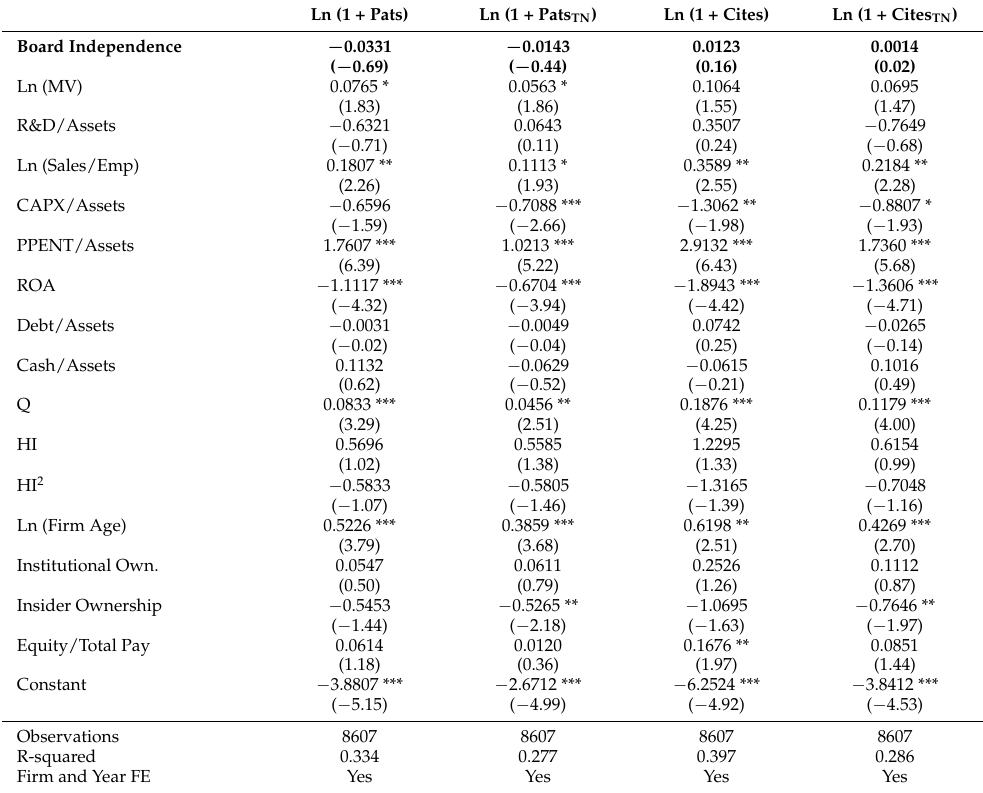
Table 8. Regressions of Innovation on Board Structure. This table presents regression results of Innovation on Board Independence, defined as the percentage of directors who are independent. All except binary variables are winsorized at the upper and lower 1% levels. Full variable definitions are provided in the Appendix A. T-statistics are reported in parentheses. Standard errors are adjusted based on the Huber–White sandwich estimate of variances and are clustered by firm. *** indicates significance at the 1% level, ** 5% and *